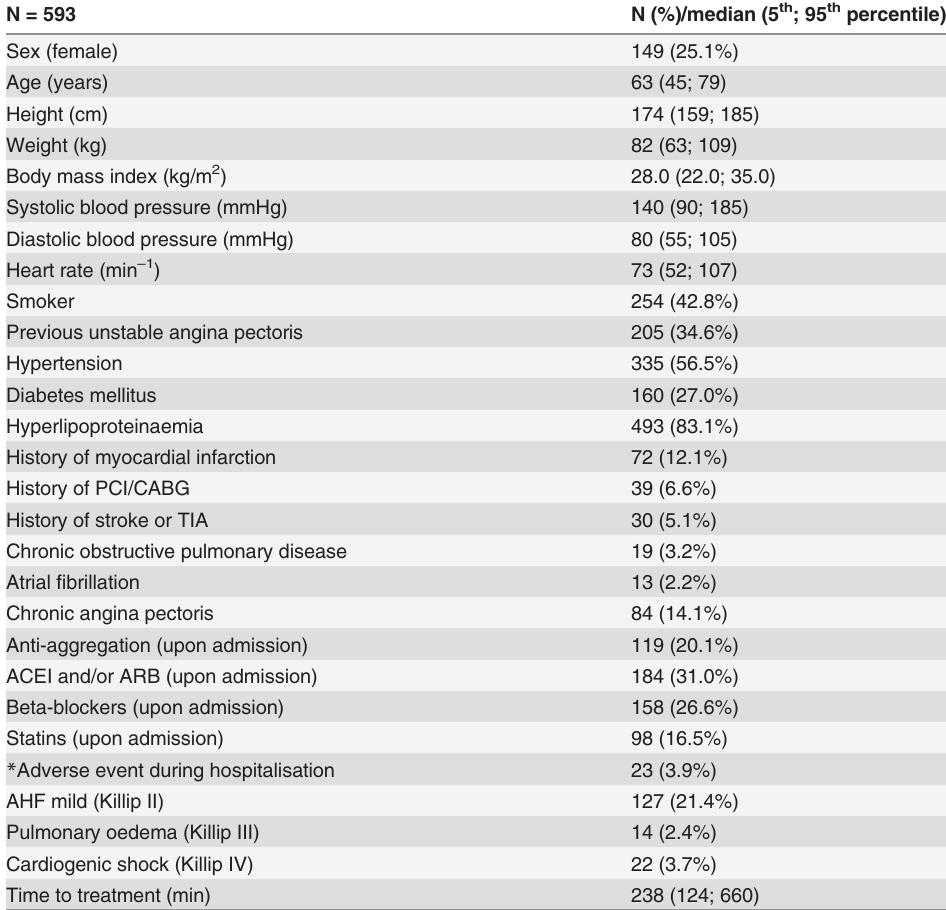
Table 2. Baseline characteristics of patients and medical therapy upon hospital